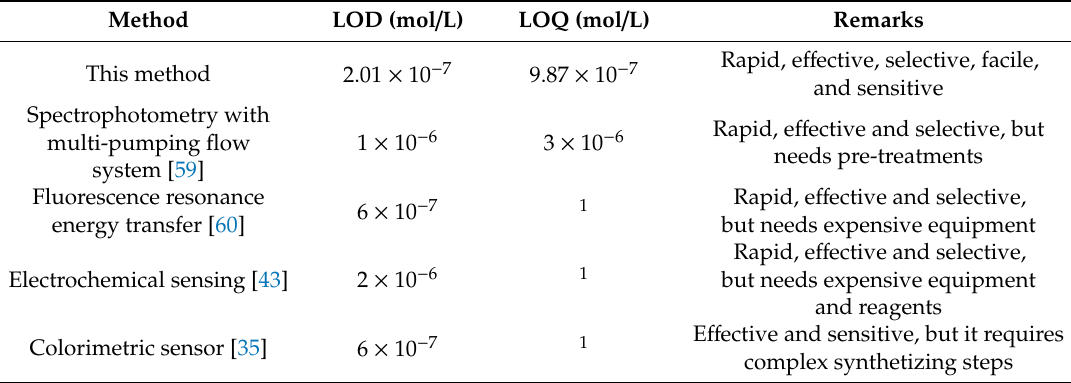
Table 1. Comparison between other glyp determination in